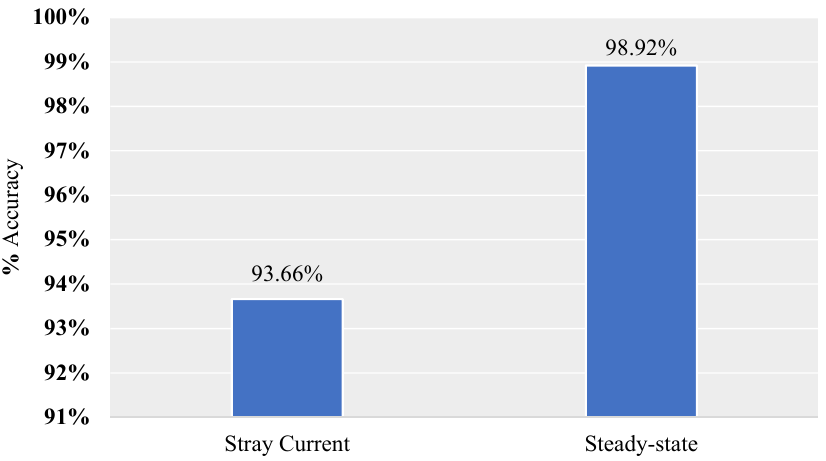
Figure 16. FDU CP pipe potential state prediction results.